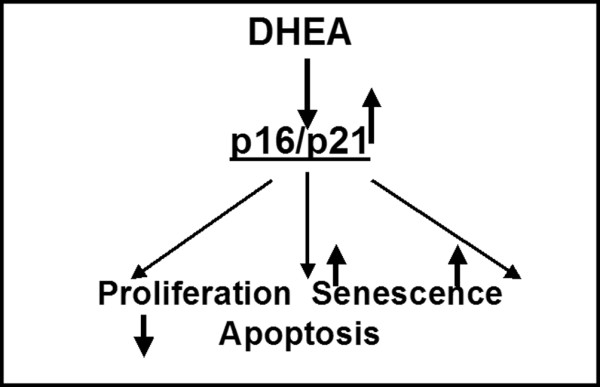
A hypothetical model of inhibition of mammary carcinogenesis by DHEA. Our data indicate that DHEA, by increasing p16 and p21 expression, may suppress cell proliferation and induce senescence and apoptosis. The arrows indicate the changes in the corresponding parameters.